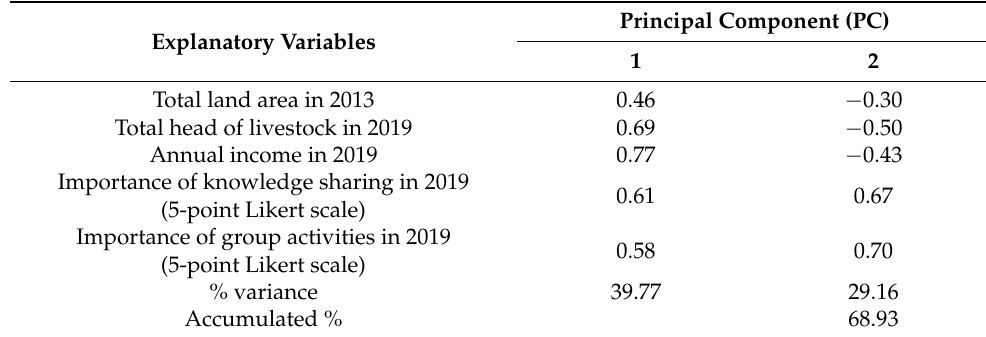
Table 6. Factor loadings of principal components (PCs) 1 and 2 for households obtained from the principal component analysis